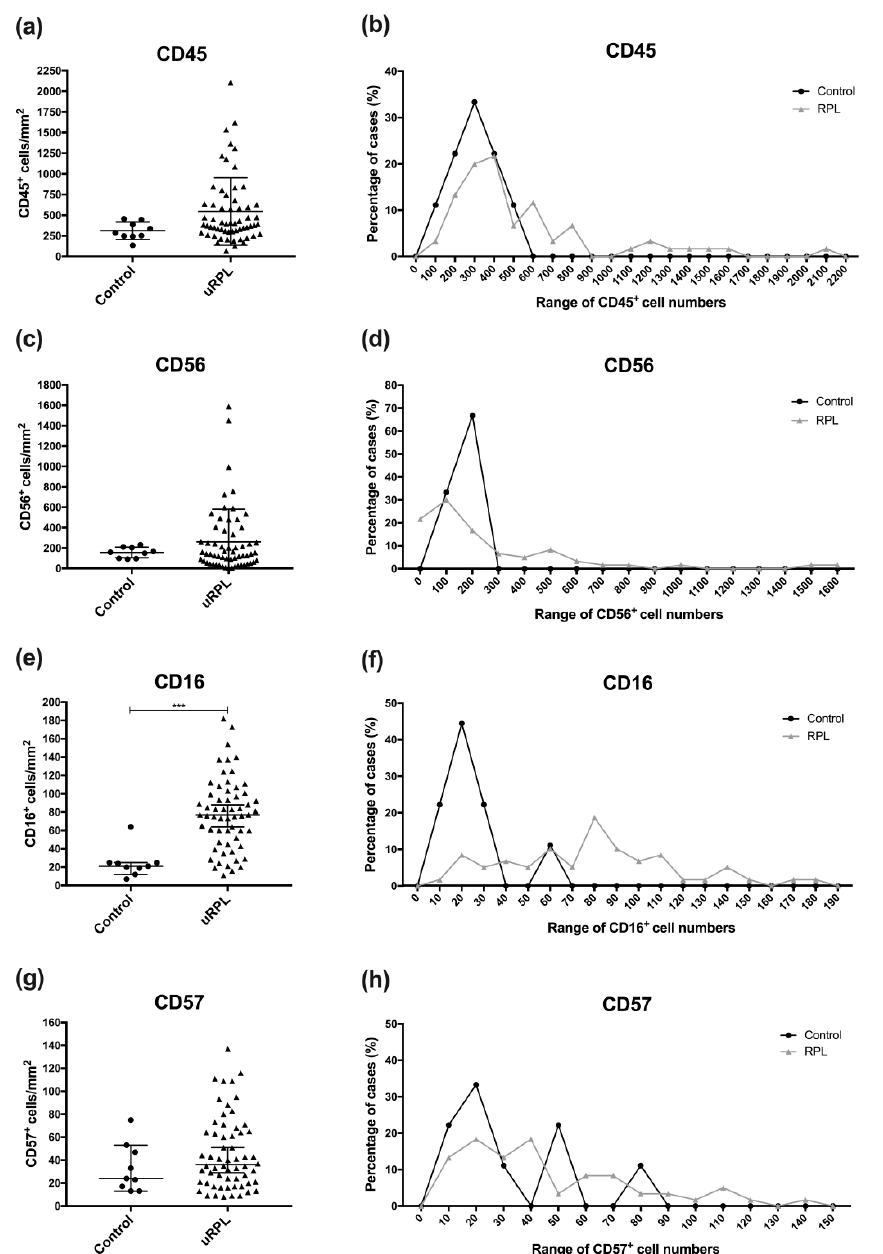
Figure 5. Mean values and frequency distribution of cell count ranges for CD45 ( a , b ), CD56 ( c , d ), CD16 ( e , f ), and CD57 ( g , h ) in the endometrium of controls ( n = 10) and uRPL cases ( n = 61): ( a , c , e , g ) Cell counts of all individual samples, their mean, and standard error and ( b , d , f , h ) the distribution of values from samples classified in ranges of 100 cells / mm 2 (CD45 and CD56) or 10 cells / mm 2 (CD16 and CD57). The relative frequency shows the percentage of samples in the respective range. Values are expressed in cells / mm 2 . *** p < 0.001, Mann–Whitney test.